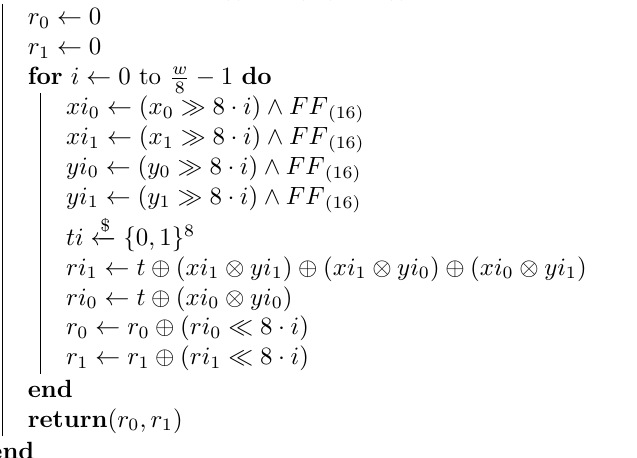
multiplication operation (under Boolean 2 8